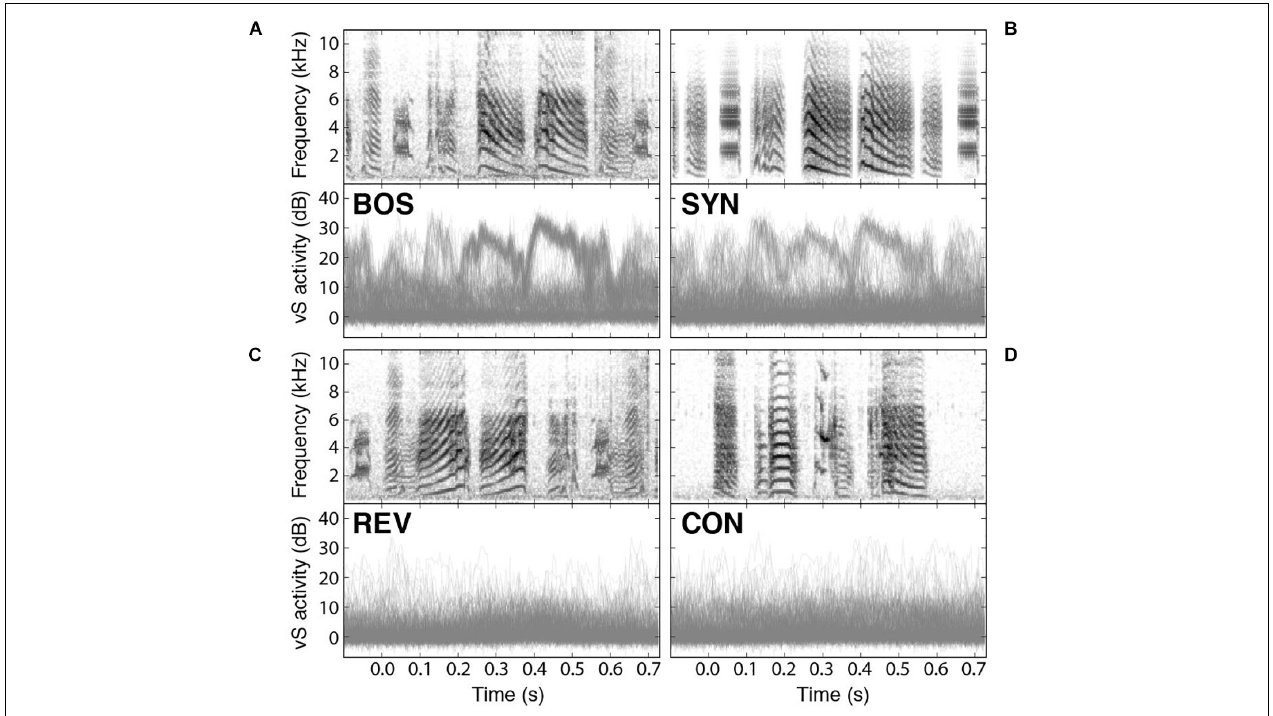
FIGURE 5 | Syringeal muscle activity is selectively evoked by auditory playbacks. Playback responses in sleeping zebra finches to (A) the bird’s own song (BOS), (B) a synthetic copy of the bird’s own song (SYN), (C) the bird’s own song played in reverse (REV), and (D) a conspecific song (CON). In all cases, the top panel shows the spectrogram of the auditory stimulus presented, and the bottom panel shows an overlay of all recorded vS responses to those songs. Adapted from Bush et al.,